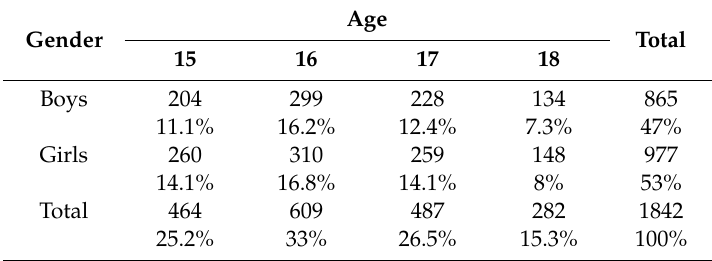
Table 1. Sample distribution across gender and